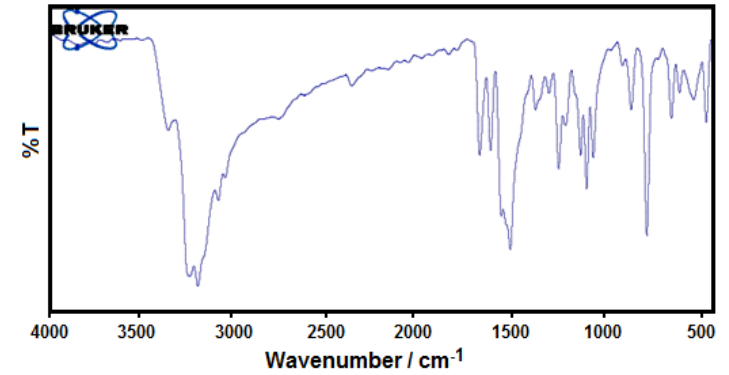
Fig. 1. FT-IR spectra of Cu nanocomplex